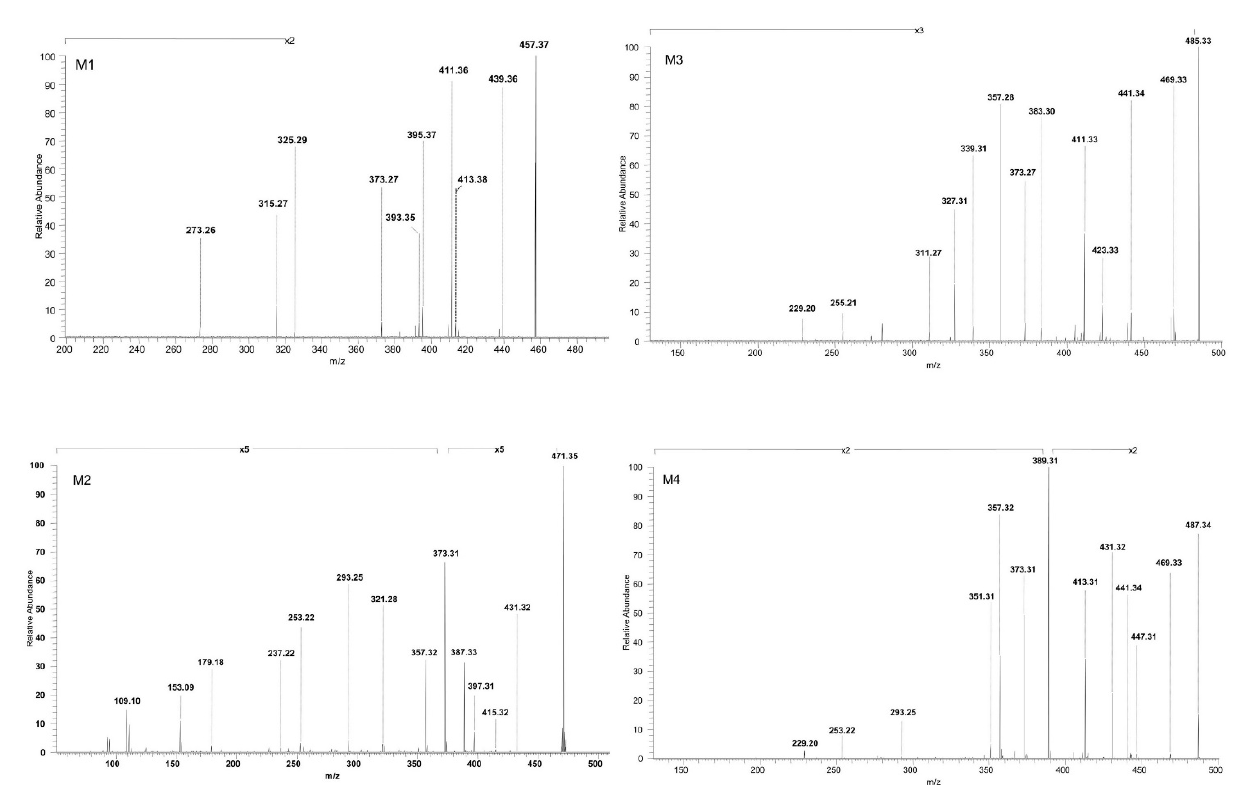
Figure 3. ESI CID MS/MS spectra in the negative ion mode of phase I metabolites detected as [M − H] − ions: M1 ( m/z 457.37), M2 ( m/z 471.35), M3 ( m / z 485.33) and M4 ( m / z 487.34); spray voltage 0.70 kV, capillary temperature 275 °C and collision energies within 0–35 eV.